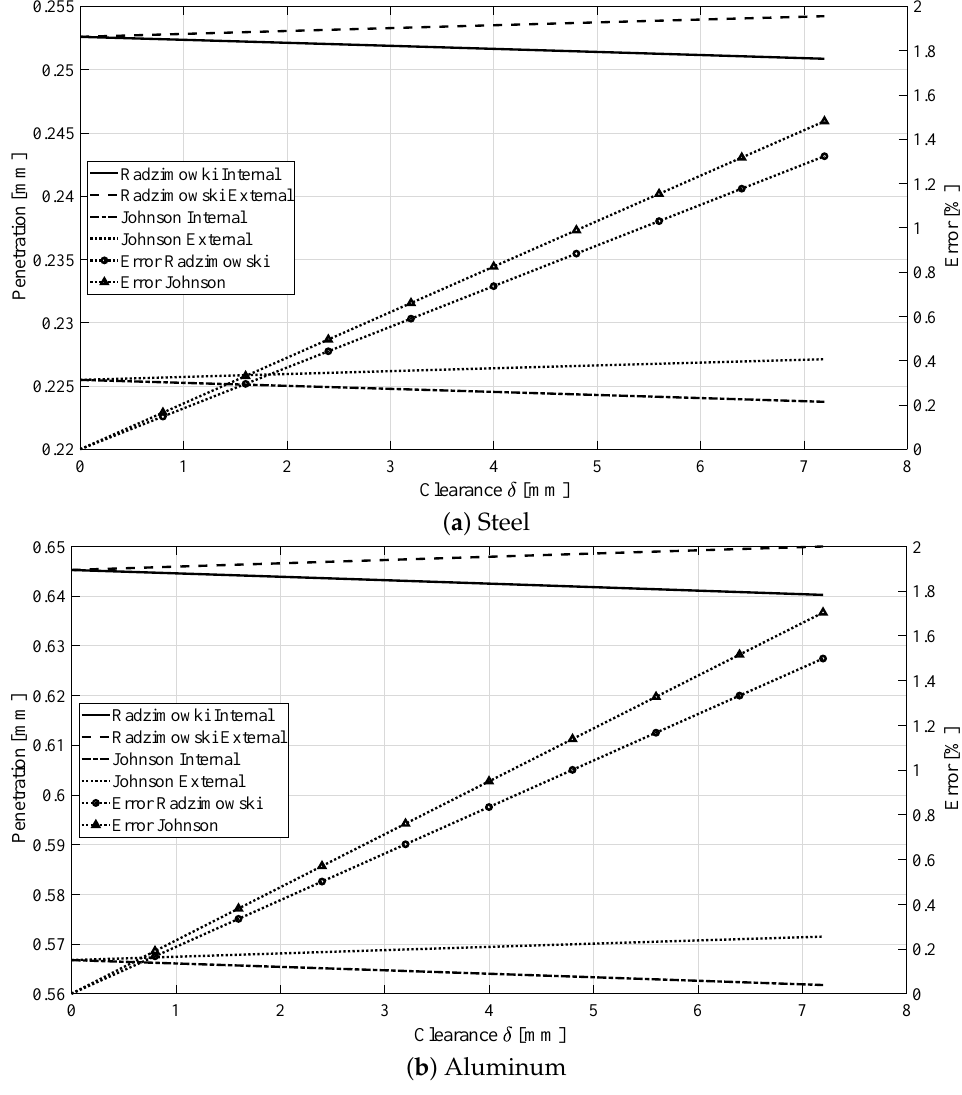
Figure 10. Effect of clearance on the error. For a complete crank rotation, the comparison of contact forces computed according to the different models is depicted in Figure 11. To minimize the effects of the initial conditions, the second full crank revolution is monitored. A region with a null contact force is visible around 100 degrees of the relative crank angle corresponding to pin-slot separation caused by